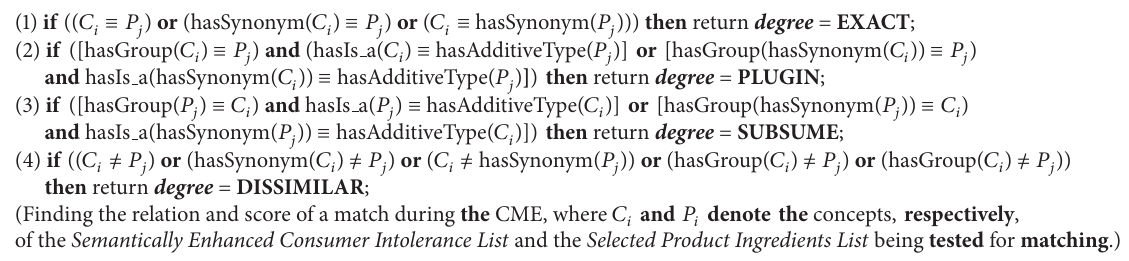
Algorithm 1: MatchingScore(Concept 𝐶 𝑖 , Concept 𝑃 𝑗